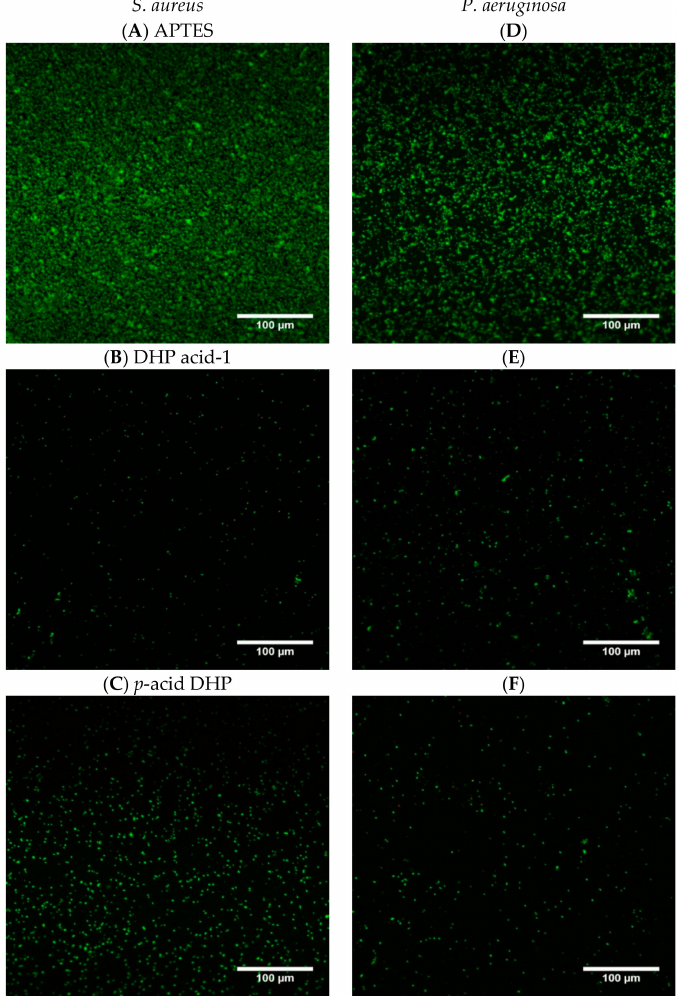
Figure 4. Confocal microscopic images of S. aureus and P. aeruginosa adhered to APTES process control ( A , D ), DHP acid-1 surfaces ( B , E ) and p -acid DHP surfaces ( C , F ). Live bacterial cells stained green and dead bacteria stained red. Magnification 200 × . Scale bar = 100 µ